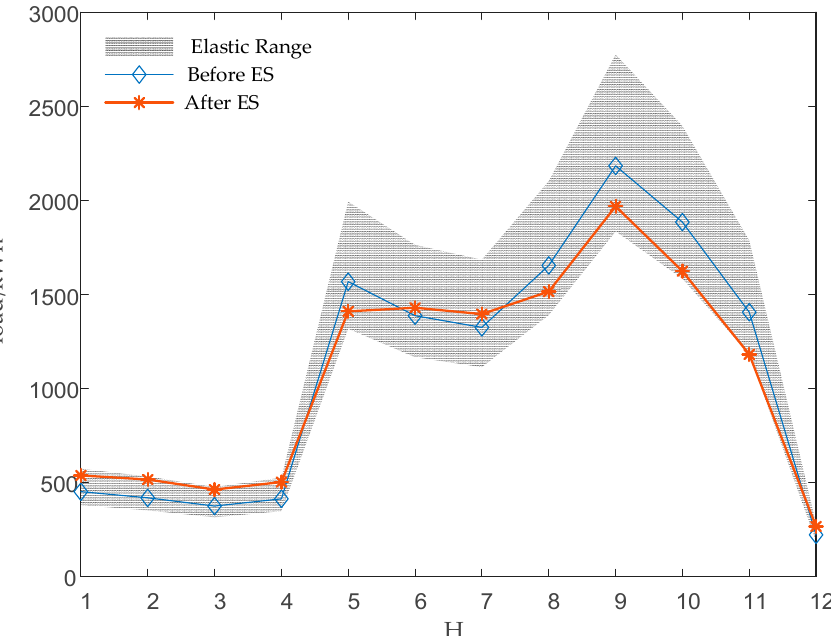
Figure 13. The load elastic range of prosumers, the comparison of load demand profile before and after ES.